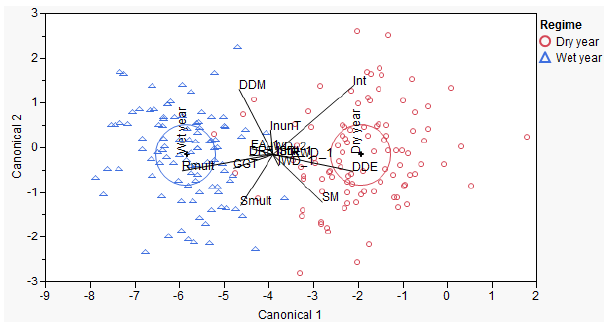
Figure 7. Separation of the behavioural parameter sets (top 100 iter- ations from MCMC) in the dry and wet year hydrologic regimes us- ing discriminant function analysis (DFA). Wet and dry year hydrol- ogy separated mainly on parameters related to evapotranspiration (DDE), interception (Int) and rain multiplier (Rmult) on canonical 1. Parameters were separated on snow multiplier (Smult), snowmelt (SM) and degree day melt factor (DDM) on canonical 2. The circles represent normal 50% contours. Parameters are defined in Table